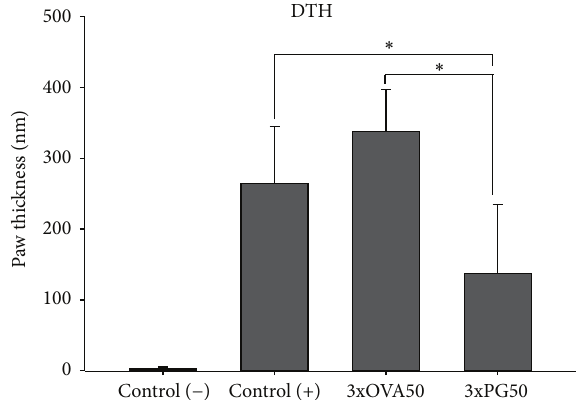
Figure 5: Delayed-type hypersensitivity reaction elicited by PG in mice previously inoculated with PG or OVA. Paw thickness was measured before and 24 hours after PG challenge using a caliper. Control ( − ): healthy group not previously injected with PG; control (+): arthritic group not previously injected with PG; 3xPG50: arthritic group previously injected with three doses of PG (50 𝜇 g). Four to six animals per group from one representative experiment of two performed. ∗ 𝑝 < 0.05